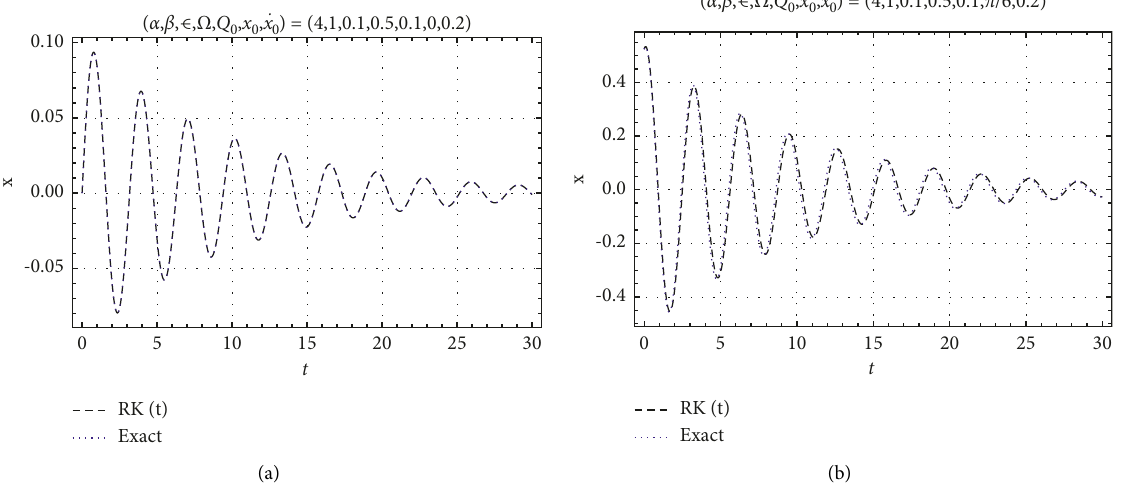
Figure 1: Both exact solution (6) and RK numerical solution to the damped Mathieu equation (4) are compared with each other for different values to the initial amplitude x 0